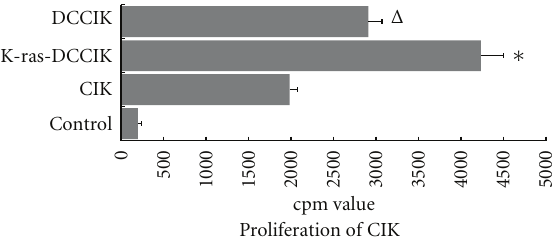
Figure 4: The proliferation activity of CIK cultured with K-ras antigen-pulsed DC (experiment 2.3, 2.4). When cultured for 14 days, proliferation capacity of K-ras-DCCIK was remarkably greater than other groups ( ∗ P < 0 . 01). And DCCIK proliferation was also greater than CIK ( Δ P < 0 . 05). It is proved that K-ras-DC can stimulate the proliferation of CIK e ff ectively.